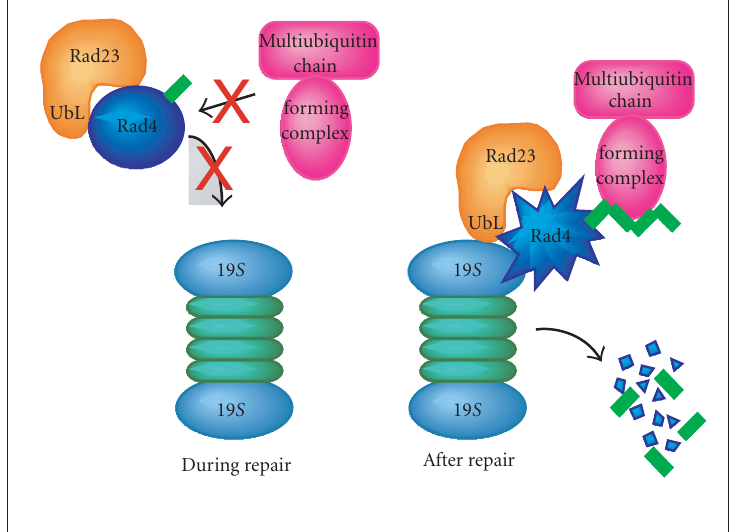
Figure 4. A model for regulation of repair by protein degradation. The ubiquitylation and degradation of specific repair proteins is inhibited in the presence of DNA damage. However, upon completion of repair, factors such as Rad23 might translocate repair proteins to the proteasome to promote degradation. Rad4 is a potential proteolytic target for Rad23, though there may exist other repair proteins that are degraded by the proteasome following the completion of DNA repair. It is also conceivable that negative regulators of NER, which suppress the activity of this repair pathway, are degraded following exposure to DNA-damaging